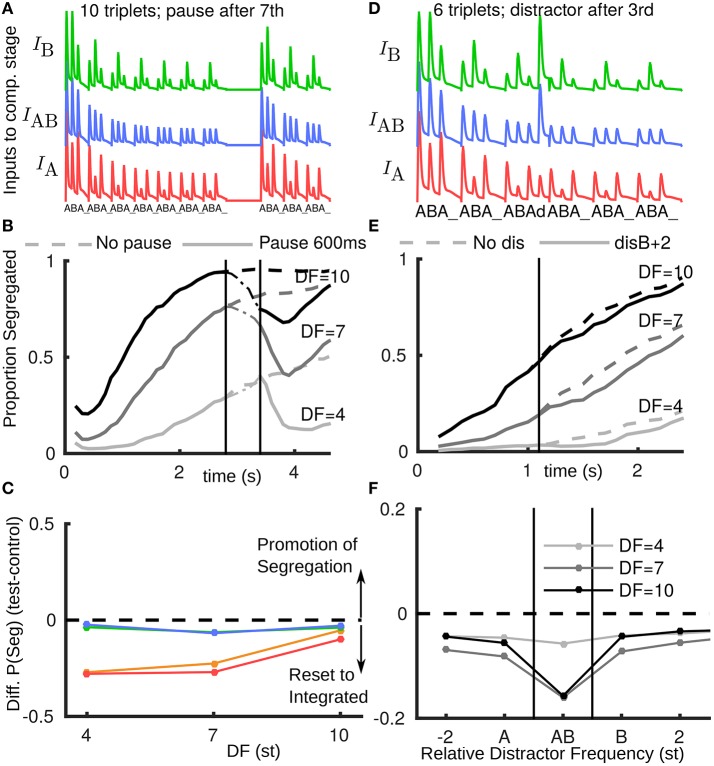
Rapid recovery of adapted A1 neural responses explains reset to integration after pauses in the model. (A) A1 responses fed as inputs to competition stage with a pause in presentation; after pause inputs are un-adapted. (B) Build-up functions from model with stimulus as shown in A (solid). Dashed curves without pause same as Figure 1D (solid). (C) The model captures the effect of stimulus pauses but not distractor or deviant tones (compare with Figure 2C, same color conventions). (D) Inputs to competition stage, with distractor d after third triplet at B+2 (2st above a normal B). Distractor tone response is assumed to have a normal tonotopic representation in A1, but be relatively more adapted at the A-location due to higher repetition rate and immediately following an A-tone offset. Distractor tone response in A1 is boosted as input to the competition stage, so the response to d is larger than for preceding tones. (E) Build-up function with distractor tone (solid) shows slight reset to integrated in comparison with no distractor case (dashed, as Figure 1D solid). (F) Across a range of tonotopic locations for the distractor tone, the model would predict a modest reset to integrated. Effect is largest when the distractor is at (A+B)/2 (labeled AB) and the DF is large, as the AB unit in the model would receive more input than peripheral units. Note x-axis does not have fixed spacing and distance between A and B changes with DF.